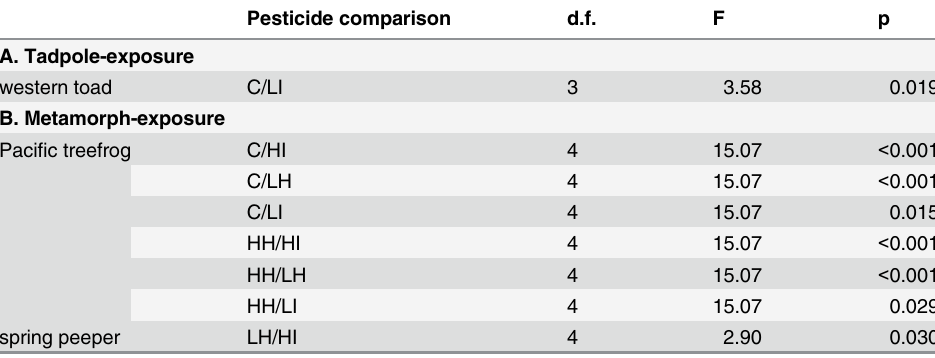
All statistically signi fi cant comparisons are shown. C = control, HH = high herbicide, HI = high insecticide, LH = low herbicide, LI = low